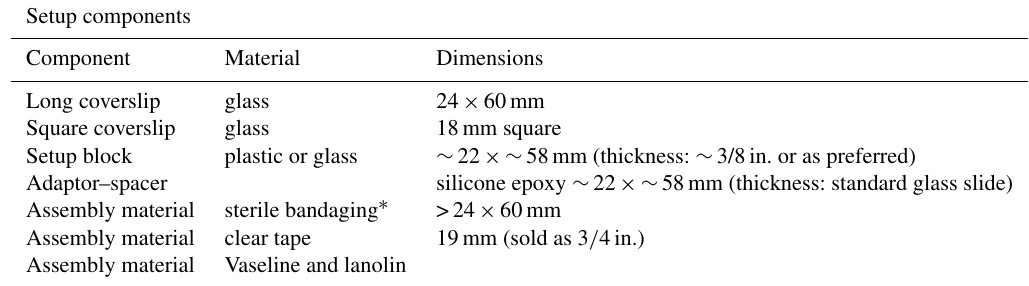
Figure 1. Specifications and assembly of unit. (a) Setup block diagram and specifications; (b) adaptor–spacer diagram; (c) exploded view showing assembly order; (d) assembled setup, isometric view; (e) a version of a live setup, viewed from above and showing Liesegang banding. Table 1. Dimensions of the setup block and adaptor–spacer should be slightly narrower and shorter than the long coverslip. Setup